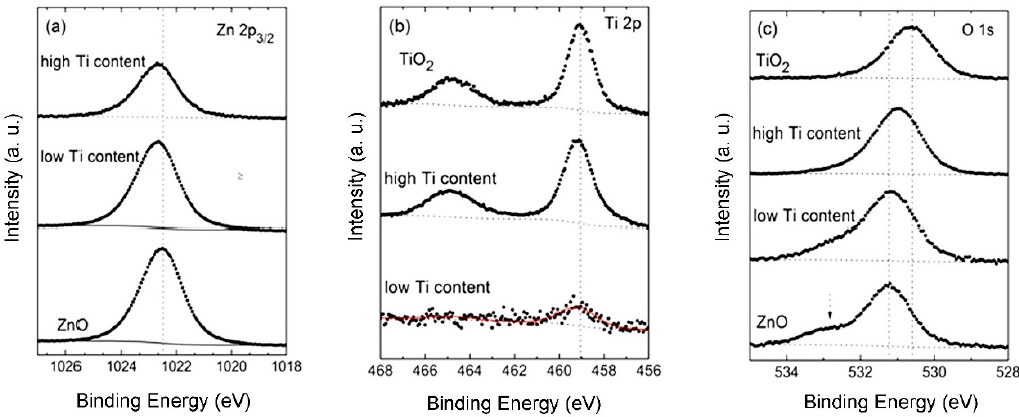
Figure 4. Spectra of Zn 2 p ( a ), Ti 2 p ( b ) and O 1 s ( c ) of the TZO films with low (approx. 0.9 at.%) and high ( ≥ 18 at.%) Ti content, including the reference ZnO and TiO 2 samples: The vertical dotted lines represent the position of the reference energy of the ZnO ( a ), TiO 2 ( b ), and O–Zn and O–Ti ( c ) chemical bonds.